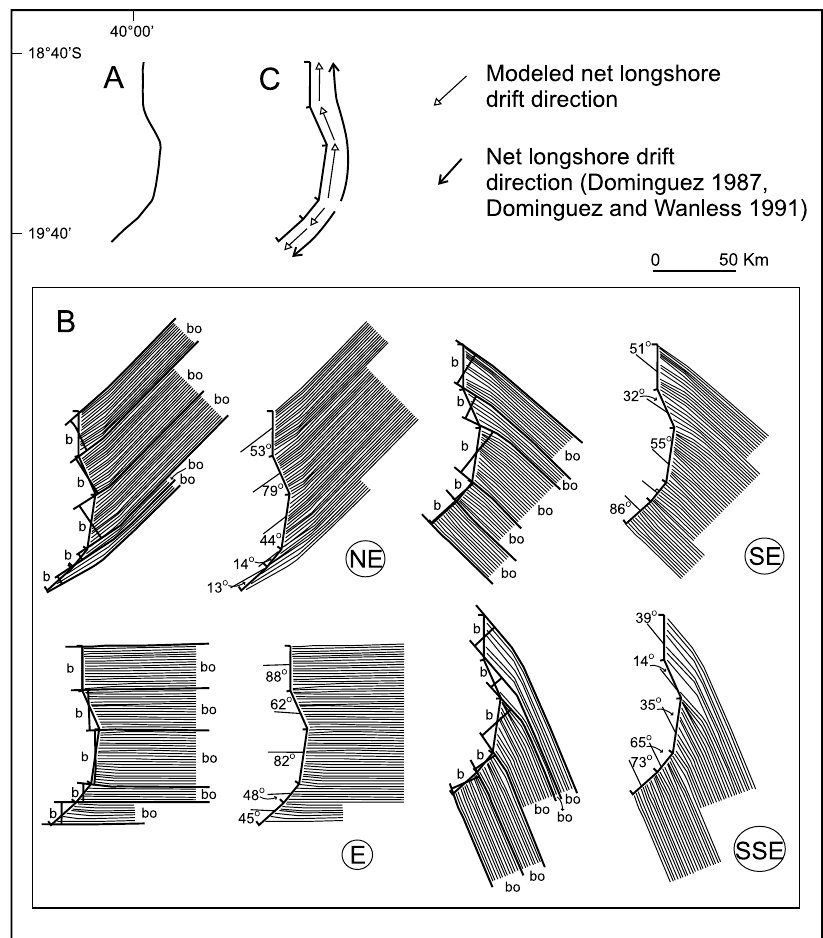
Fig. 5 – (A) Coastline in the Doce River immediately after 5600 cal yr BP (see Fig. 3). (B) Refraction diagrams for waves with a 5-s period, coming from NE and E, and 6,5-s period, coming from SE and SSE. Here are also shown: 1) different segments into which the shoreline was rectilinearized, 2) incidence angles formed by the wave-rays in relation to the coastal segments and 3) measurements of b and b o (see text) used to estimate wave height along the shore segments. (C) Rectilinearized shoreline showing the directions of net longshore drift of sediments estimated from numerical modeling and from Dominguez (1987) and Dominguez and Wanless